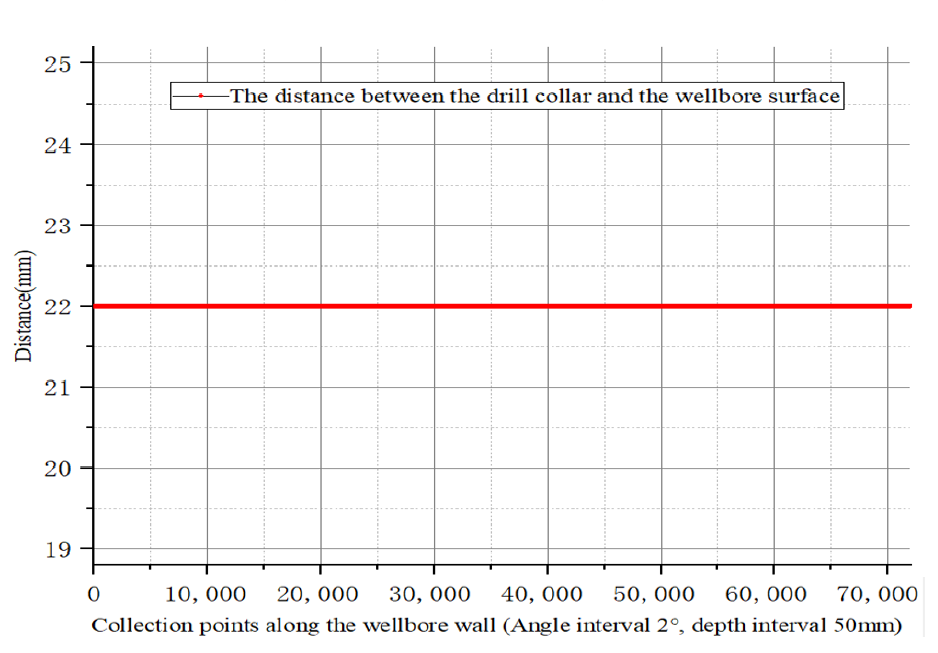
Figure 8. The eccentric distance of the drill collars running in the center of the